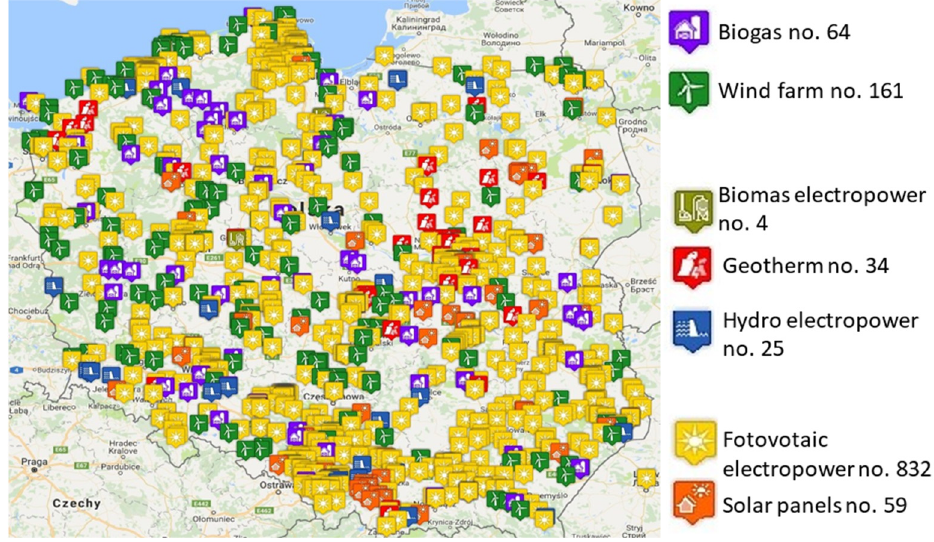
Figure 1. Distribution of renewable power installations in Poland.